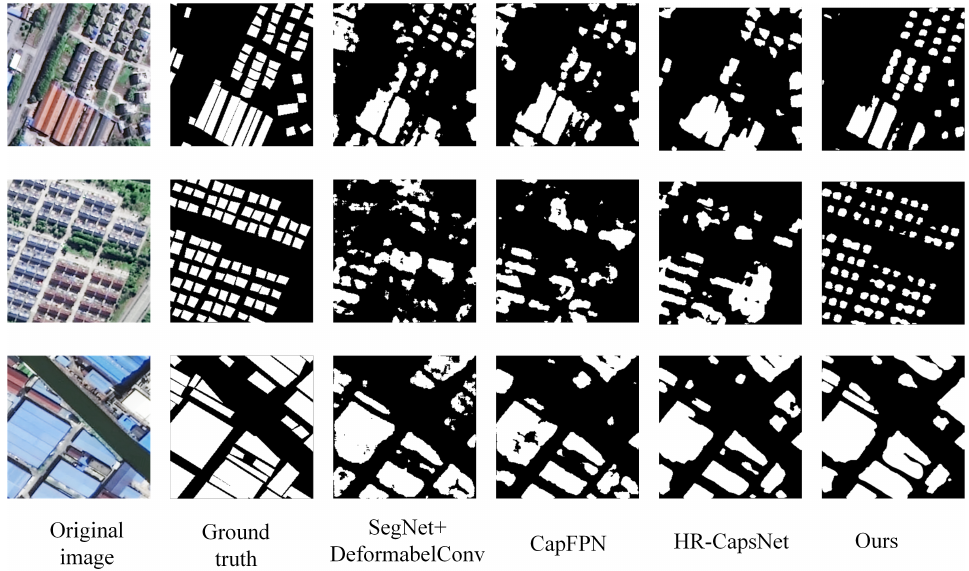
Figure 12. Comparison of the building extraction of different methods on the Yellow River dataset (WHU dataset as the source